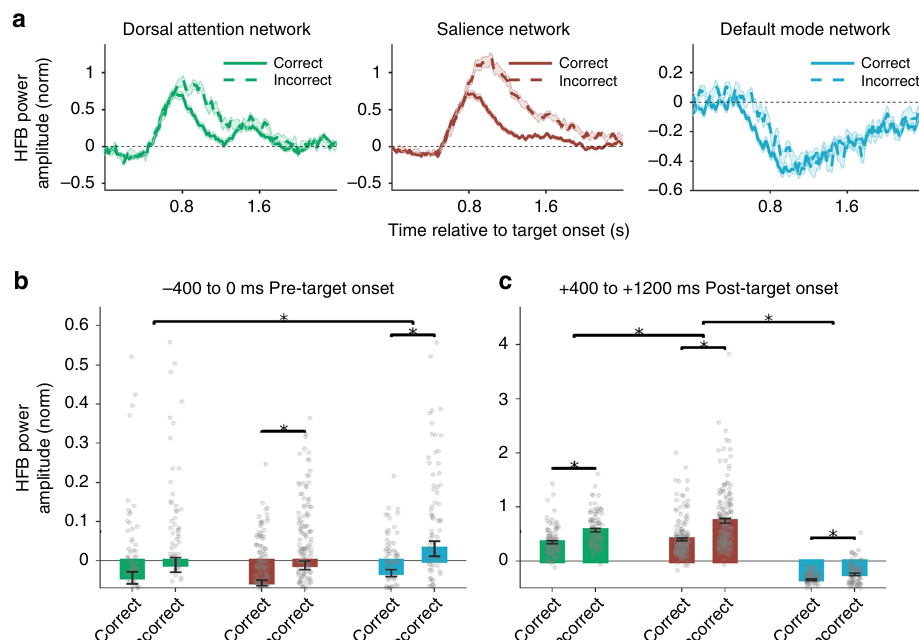
Fig. 4 Network-speci fi c pro fi les of task-evoked HFB activity during and preceding behavioral errors. a High-frequency broadband responses during the presentation of mountain (target) stimuli, split into trials with correct and incorrect behavioral responses. Time courses show the grand average of the trial- wise means within all task-responsive electrodes ( p < 0.05, cluster-based permutation test, corrected for multiple comparisons within networks within subjects). b Mean HFB power amplitude within the − 400 to 0 ms window relative to target onset. c Mean HFB power amplitude within the + 400 to + 1200 ms window relative to target onset. In b and c , bars show the mean of normalized HFB within all task-responsive electrodes (averaged across trials) within a given network, and error bars indicate standard error of the mean across electrodes. Upper lines and asterisks indicate signi fi cant effects ( p < 0.05, Satterthwaite ’ s approximation) based on F tests of linear mixed model analyses (see Methods). Error bars indicate standard error of the